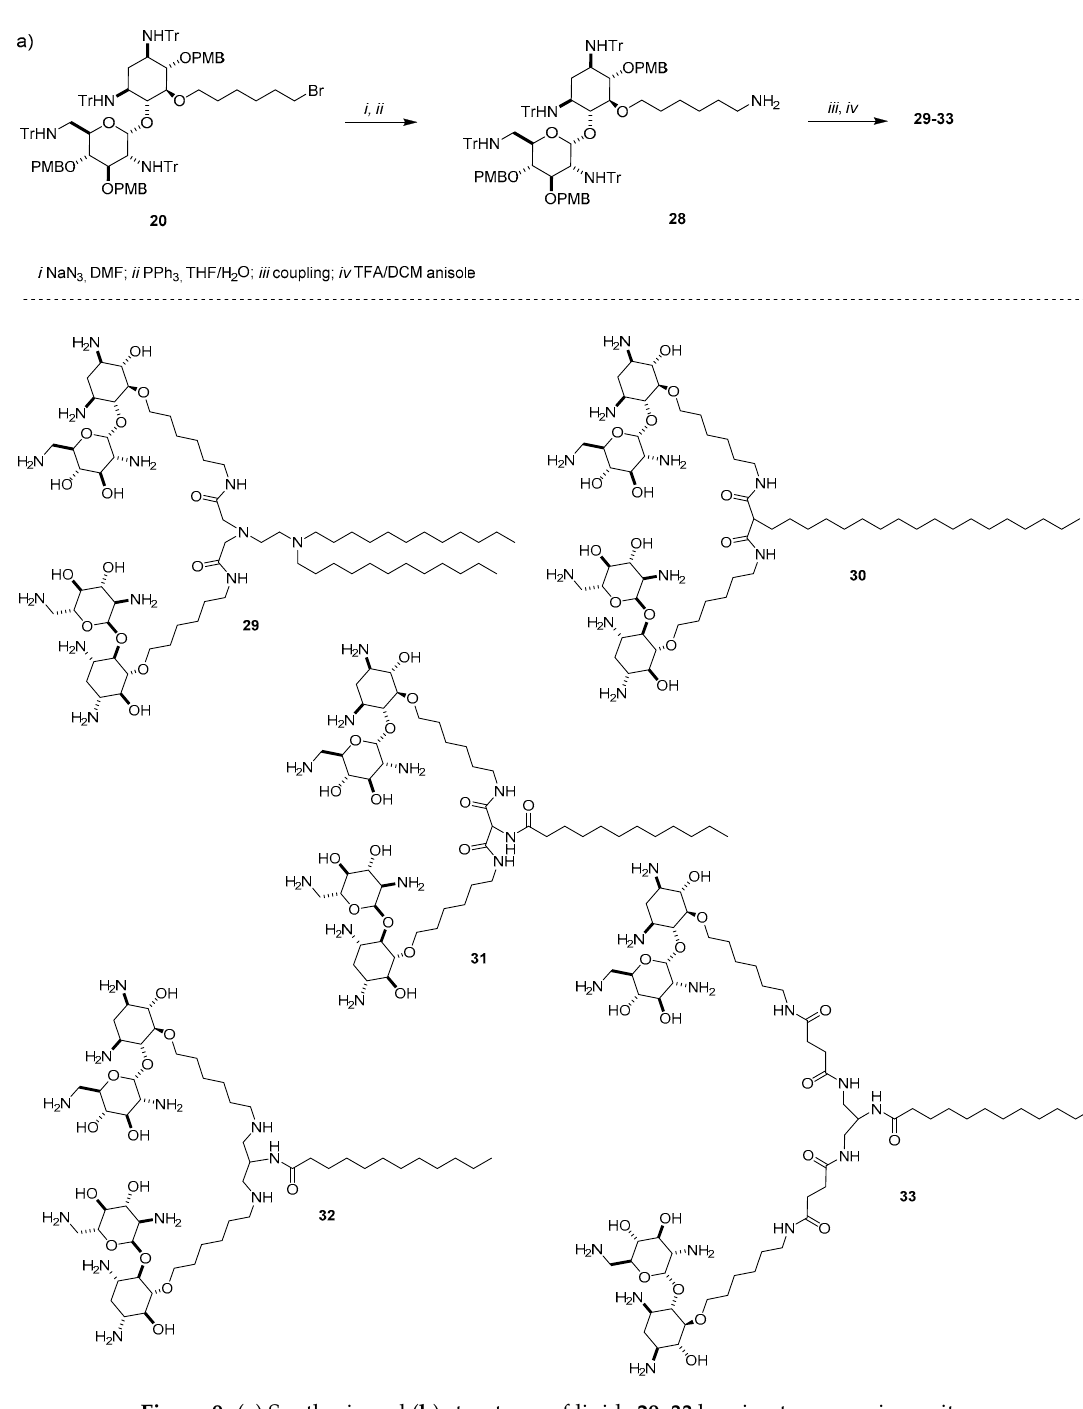
Figure 9. ( a ) Synthesis and ( b ) structures of lipids 29 – 33 bearing two neamine units.